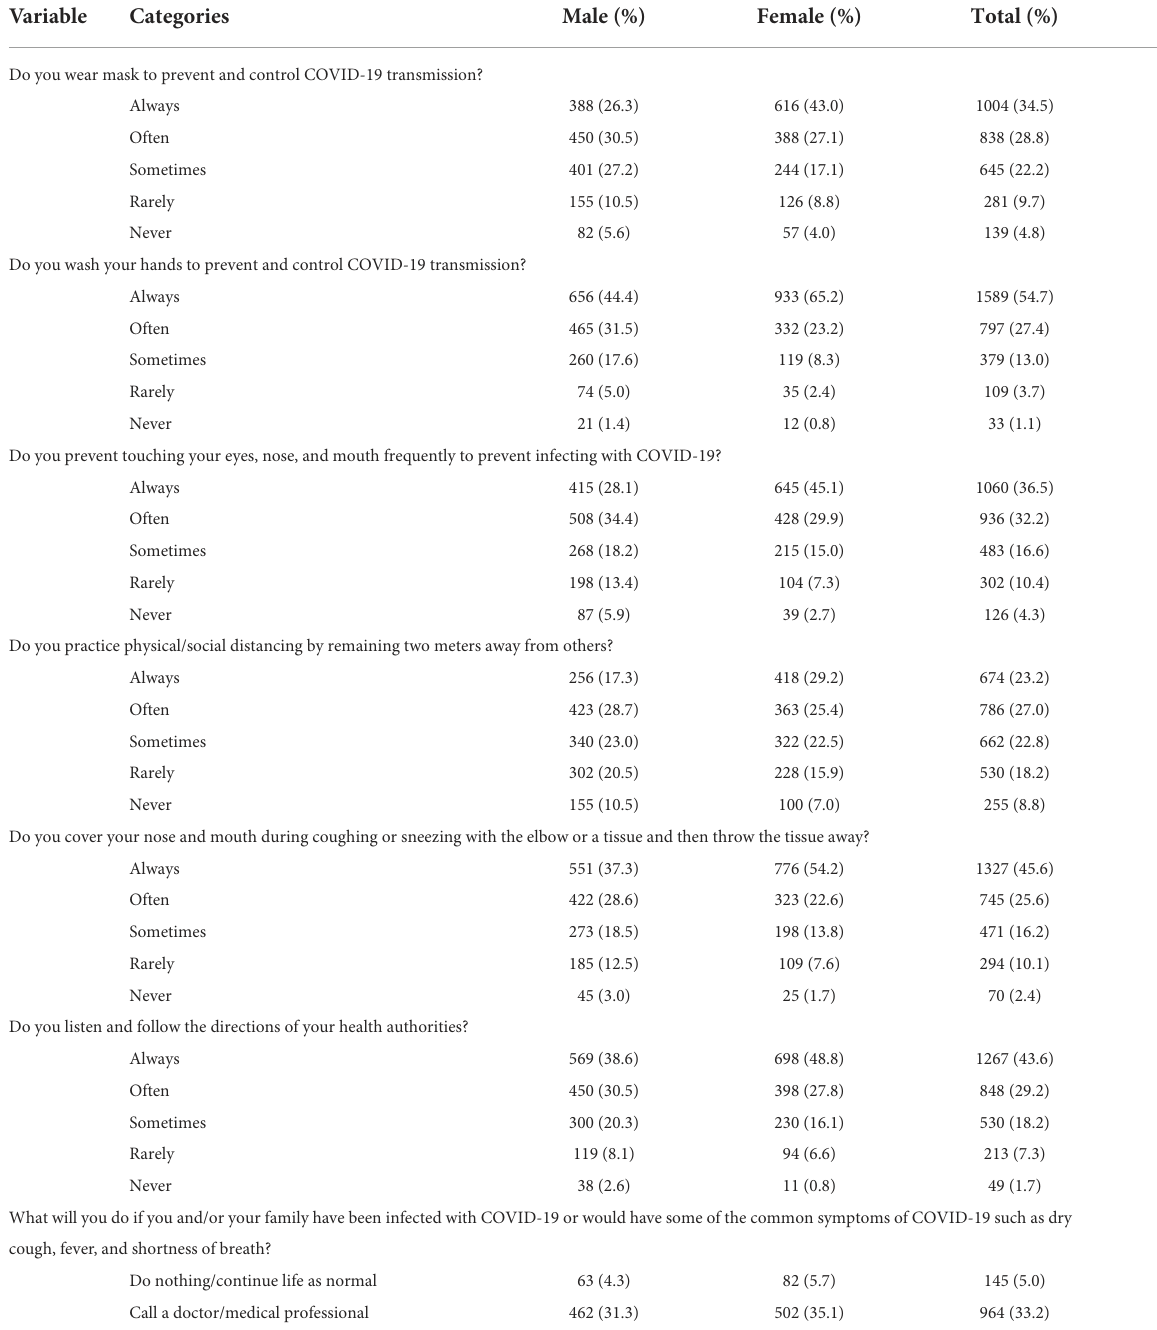
TABLE 6 Frequency distribution on practices of participants toward COVID-19 disease ( N =